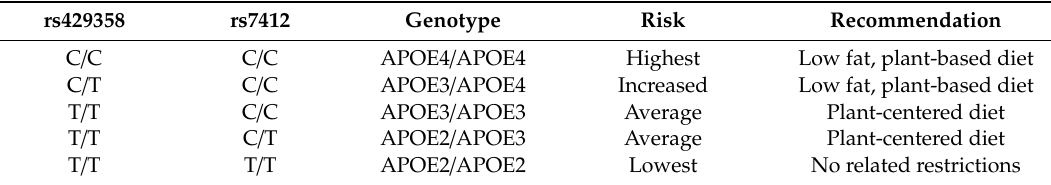
Table 3. Apolipoprotein E ( APOE ) variants and heart disease and AD